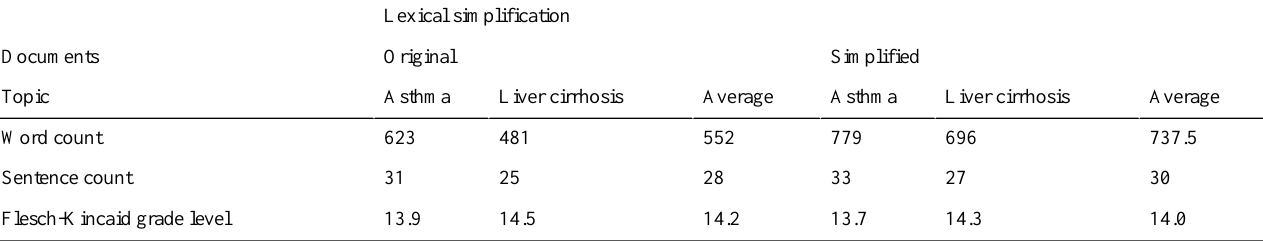
Table 2. Document characteristics.